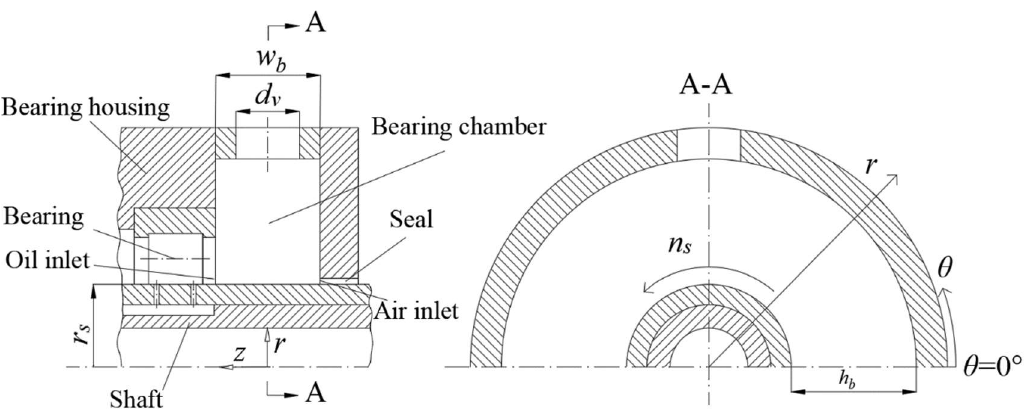
Figure 1. The structural diagram of aero-engine bearing chamber.